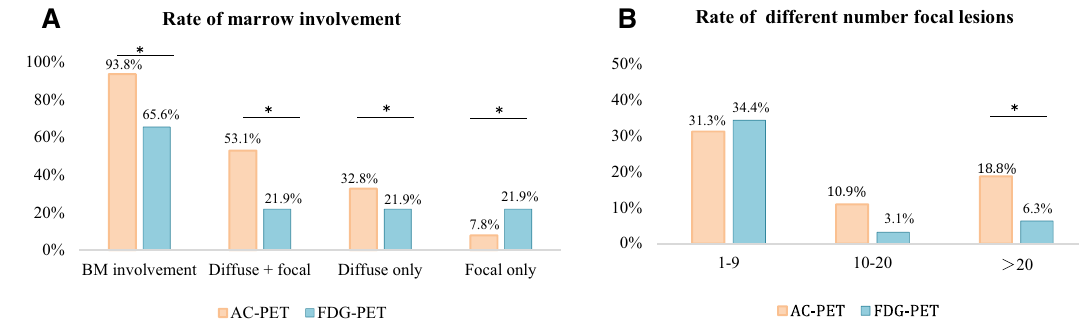
Figure 3. Tumor burden detected by AC-PET and FGD-PET in NDMM patients. ( A ) The positive rate of marrow involvement detected by AC-PET was much higher than by FDG-PET, including diffuse and focal hypermetabolic lesions, diffuse lesions only, and focal lesions only. ( B ) More focal lesions were detected in AC-PET than FDG-PET. BM: bone marrow; the chi-square test was used to compare categorical data between AC-PET and FDG-PET; * P < 0.01.